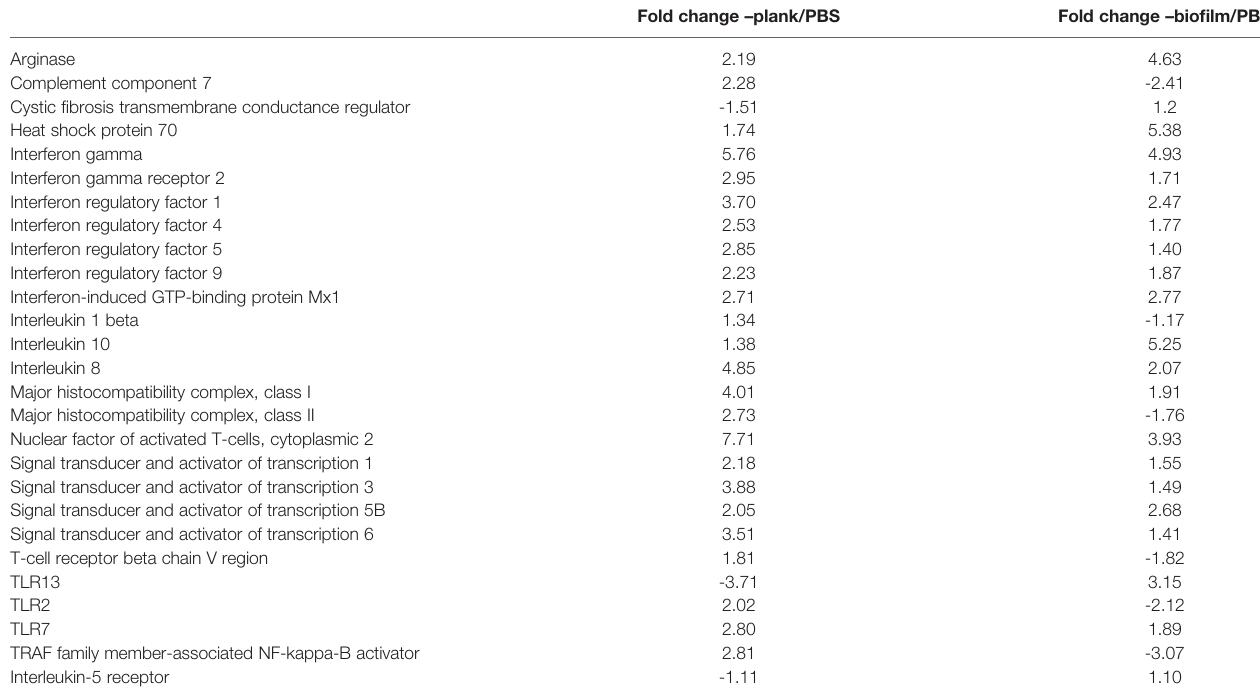
Fold change – plank/PBS Fold change – bio fi lm/PBS